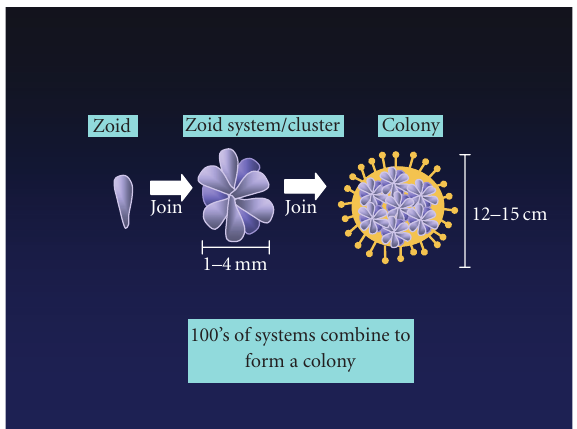
Figure 1: Botryllus schlosseri colony formation. The B. schlosseri individual is called a zooid. It attaches to the substrate that it will grow on by one end. Its free end has two openings or siphons. The zooid reproduces asexually and groups of 3–12 zooids will group together to form a cluster or system, with the free end of each zooid dumping into a central chamber. Clusters, in turn, join to form the B. schlosseri colony. All clusters in a colony are housed in a common tunic and share a common vasculature. Vessels in a colony terminate in peripheral ampullae that, while covered in the tunic, present sites of colony-to-colony